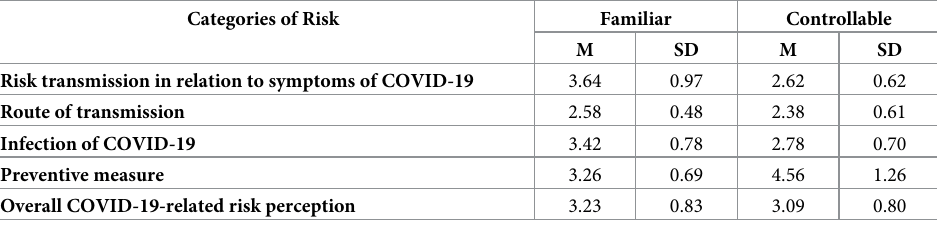
Table 2. The results of COVID-19-related risk